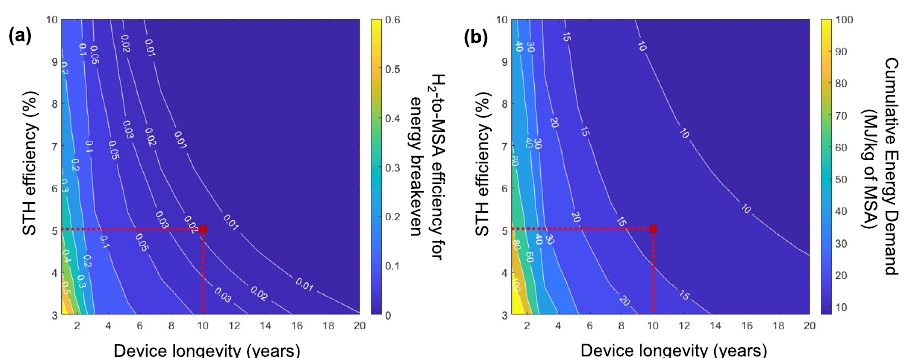
Fig. 3 | H 2 -to-MSA ef fi ciency for energy breakeven and cumulative energy demand of MSA of the coupled device. a Colormap of the required H 2 -to-MSA conversion ef fi ciency to achieve energy breakeven (i.e., zero net energy balance) for devices with various STH ef fi ciencies and device longevities. Under the base- case scenario (red dashed lines), the required H 2 -to-MSA conversion ef fi ciency is